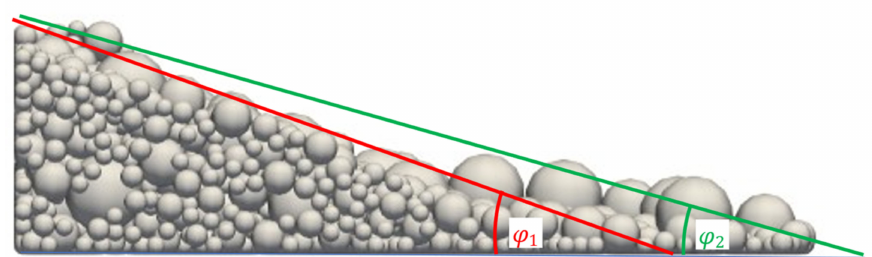
Figure 18. Varying values in shear angle calculation for curved